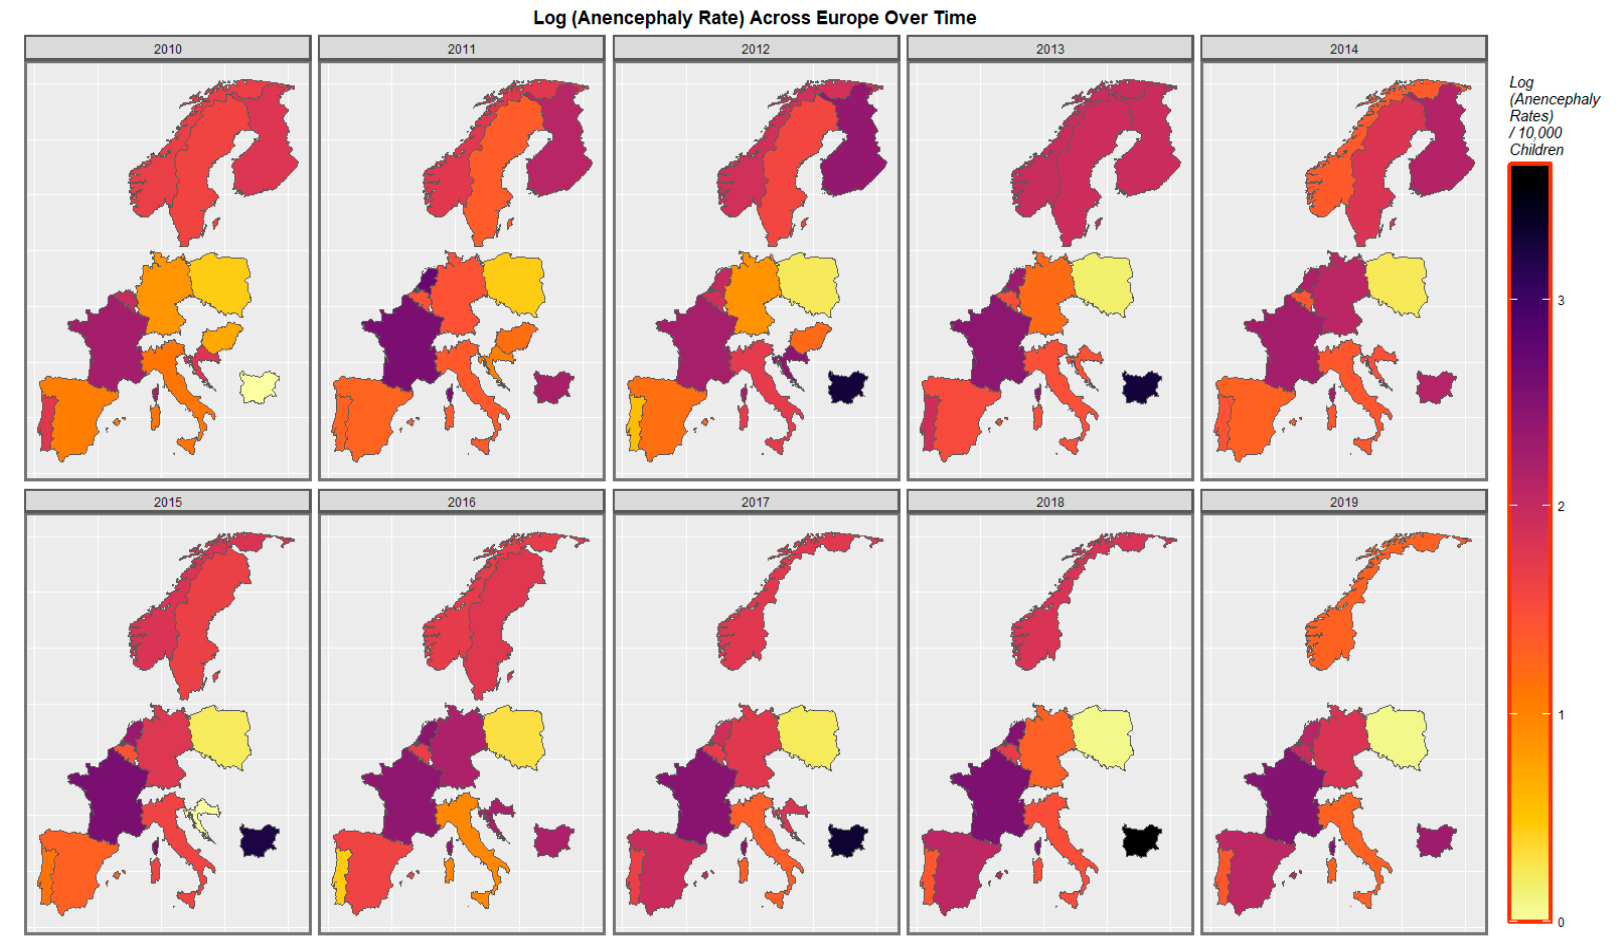
Figure 5. Sequential map-graphs of log (anencephalus rates) across surveyed European nations over time, 2010–2019.